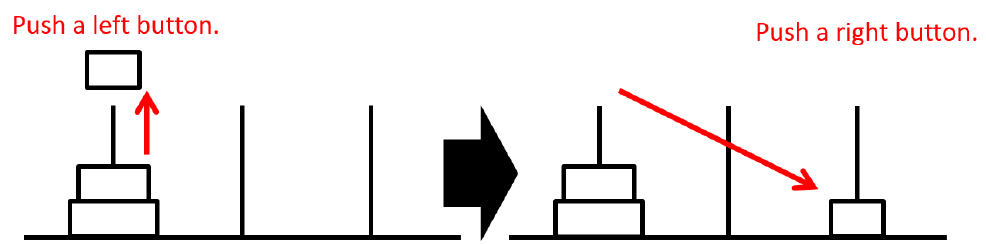
Figure 3. How to control the disks in the ToH.